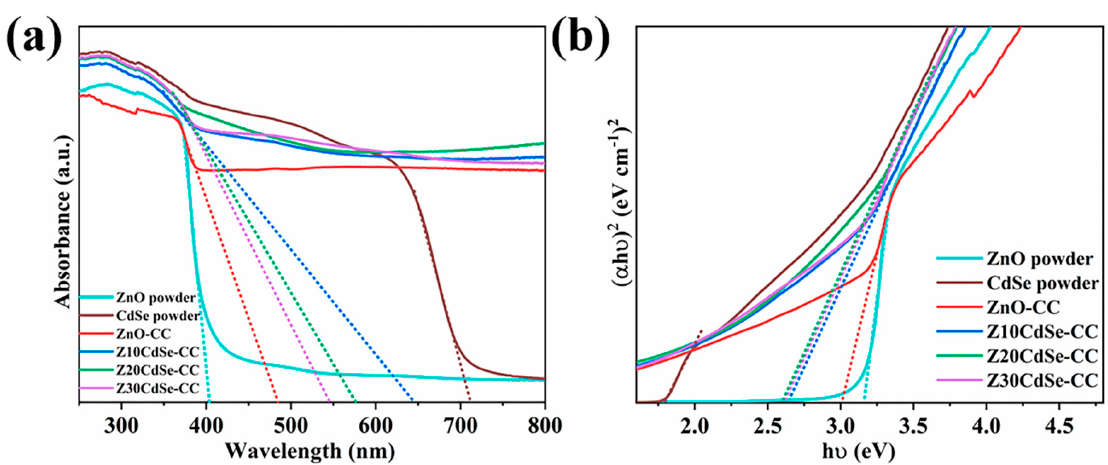
Figure 7. ( a ) UV-Vis DRS of ZnO, CdSe, ZnO–CC, and ZnO/CdSe − CC. ( b ) The spectra of ( α h ν ) 2 vs. photon energy (h ν ) of each sample.